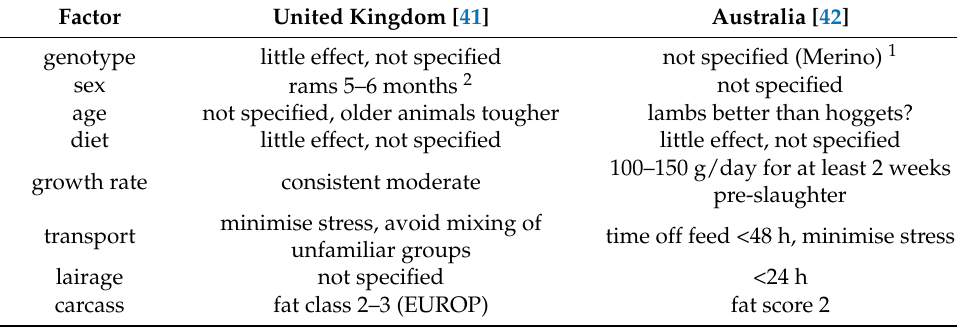
Table 1. Pre-slaughter specifications for assuring the tenderness of lamb